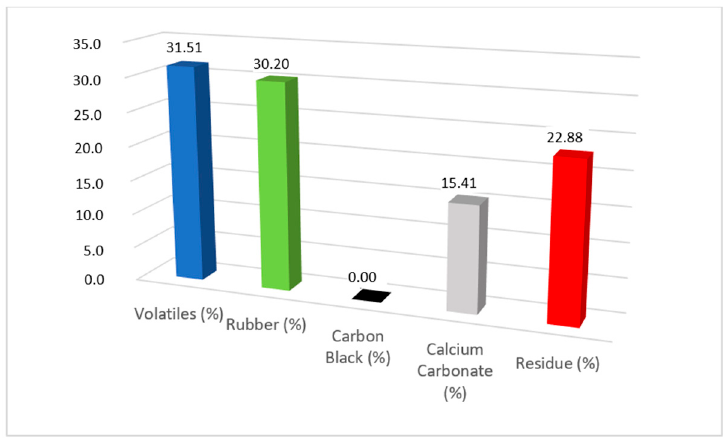
Figure 5. Composition of the original EPDM RM.